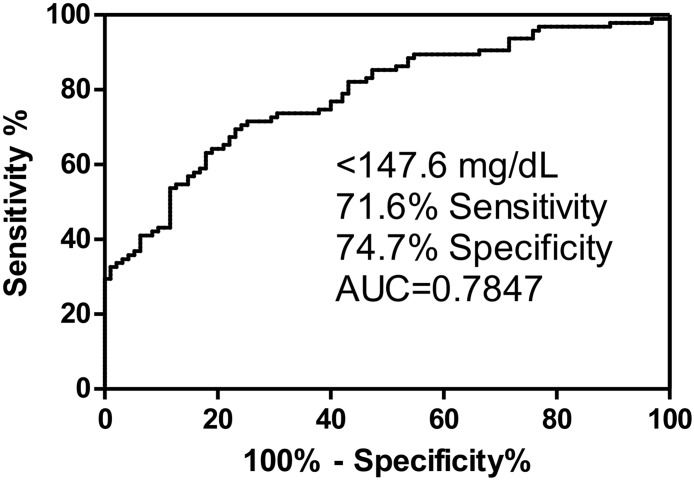
Receiver operator characteristic (ROC) curve for ApoA-I.The curve was generated from ApoA-I levels in FA cases (n = 95) versus ApoA1 levels in controls (n = 95).